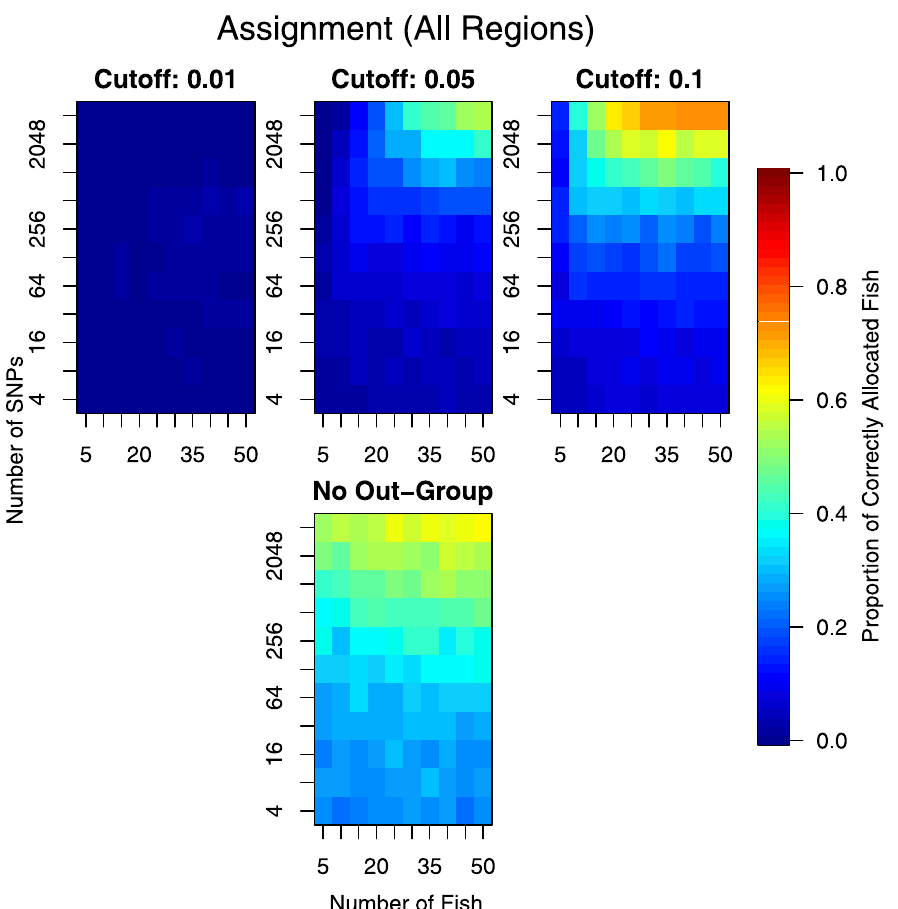
Fig 7. Results from individual assignment analysis. Lower values (cooler colours) represent poorer assignment. The top panels are for the same analysis but with different cutoff values, with a smaller cutoff (left) requiring greater dissimilarity to a location before it is considered not to be from that location. The bottom plot is for the situation where the individual was assumed to come from one of the sampled stocks (no chance of it not coming from any of them).